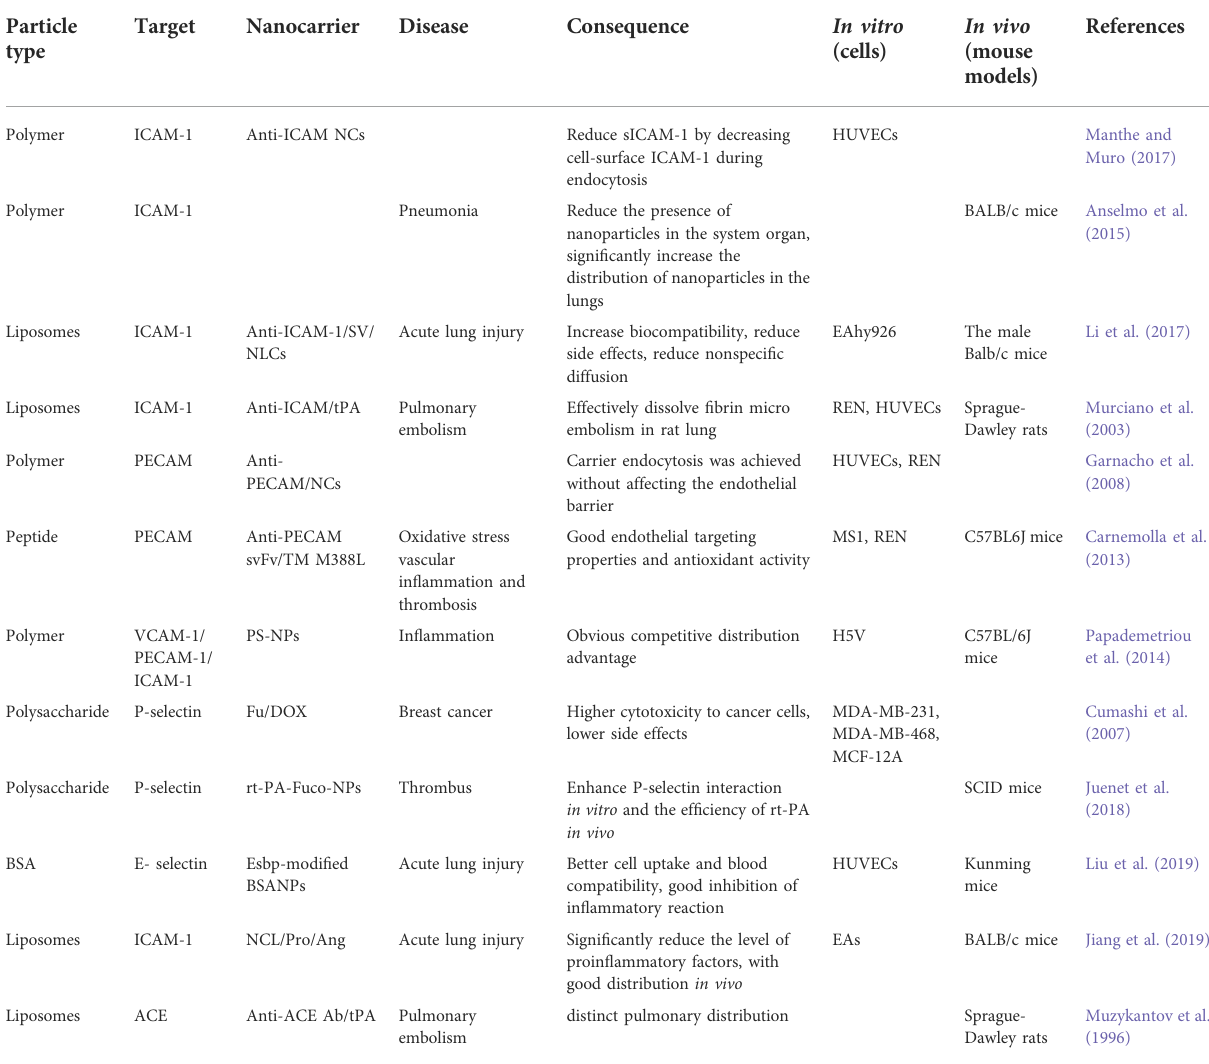
TABLE 1 Summary of drug-delivery nanoparticles targeting lung endothelial